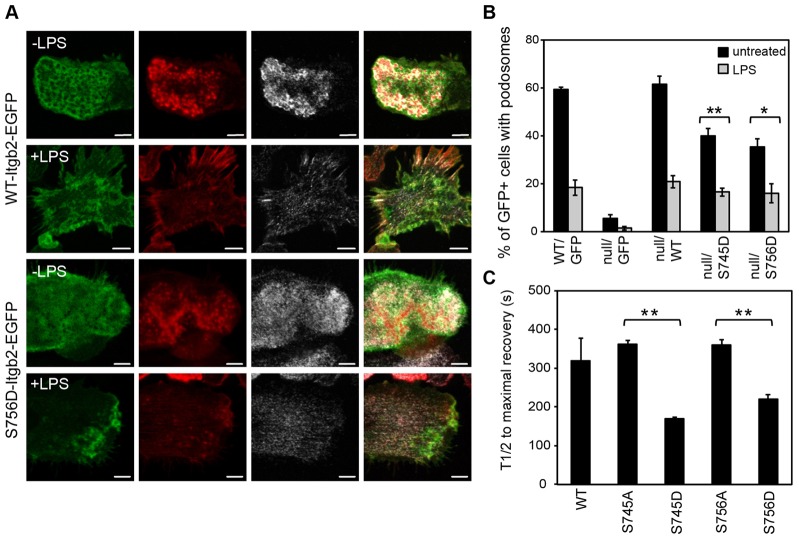
Mutation of Ser756 to Asp rescues acute LPS-driven podosome loss. (A) Itgb2-null BMDCs were infected with retroviruses containing either the WT-Itgb2-EGFP or the S756D-Itgb2-EGFP mutant constructs (green EGFP staining) and treated with (+LPS) or without (–LPS) 50 ng/ml LPS for 30 minutes before fixation and then stained to visualize F-actin (red) and α-actinin 4 (grey). Images were acquired using a Zeiss LSM700, as described for Fig. 1. The images show that podosomes formed normally in S756D-Itgb2-EGFP expressing cells and that LPS induced podosome dissolution. Scale bars: 5 µm. (B) Percentages of infected (GFP positive) cells showing podosomes when reconstituted with empty vector (pBMN-I-GFP), or constructs for WT β2 integrin or the S745D and S756D mutants, with or without LPS treatment were quantitated. Podosomes in cells expressing the S745D and S756D mutants were responsive to LPS (**P = 0.001 and *P = 0.014, unpaired t-tests). (C) Itgb2-null BMDCs expressing EGFP fusion proteins of WT, S745A, S745D, S756A or S756D-Itgb2 were cultured in glass bottom dishes for FRAP analysis, as in Fig. 4. Cells expressing Itgb2-EGFP in a typical honeycomb shaped podosome ring pattern in the ventral plasma membrane were selected for photobleaching and the half-life for fluorescence recovery measured for each construct as in Materials and Methods (ten cells per experiment). S745D and S756D mutants show reduced half-life compared to corresponding Ala mutants (**P = 0.001 and **P = 0.006, respectively, paired t-test). Data were from three independent experiments from different bone marrow and virus preparations.